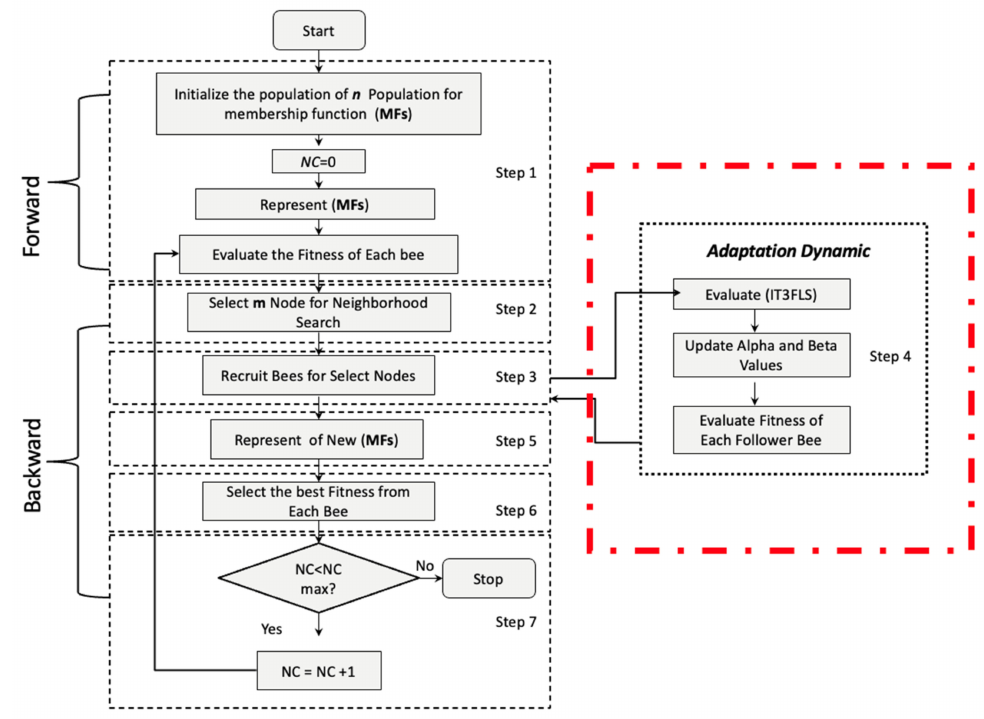
Figure 22. Flowchart of the Fuzzy BCO